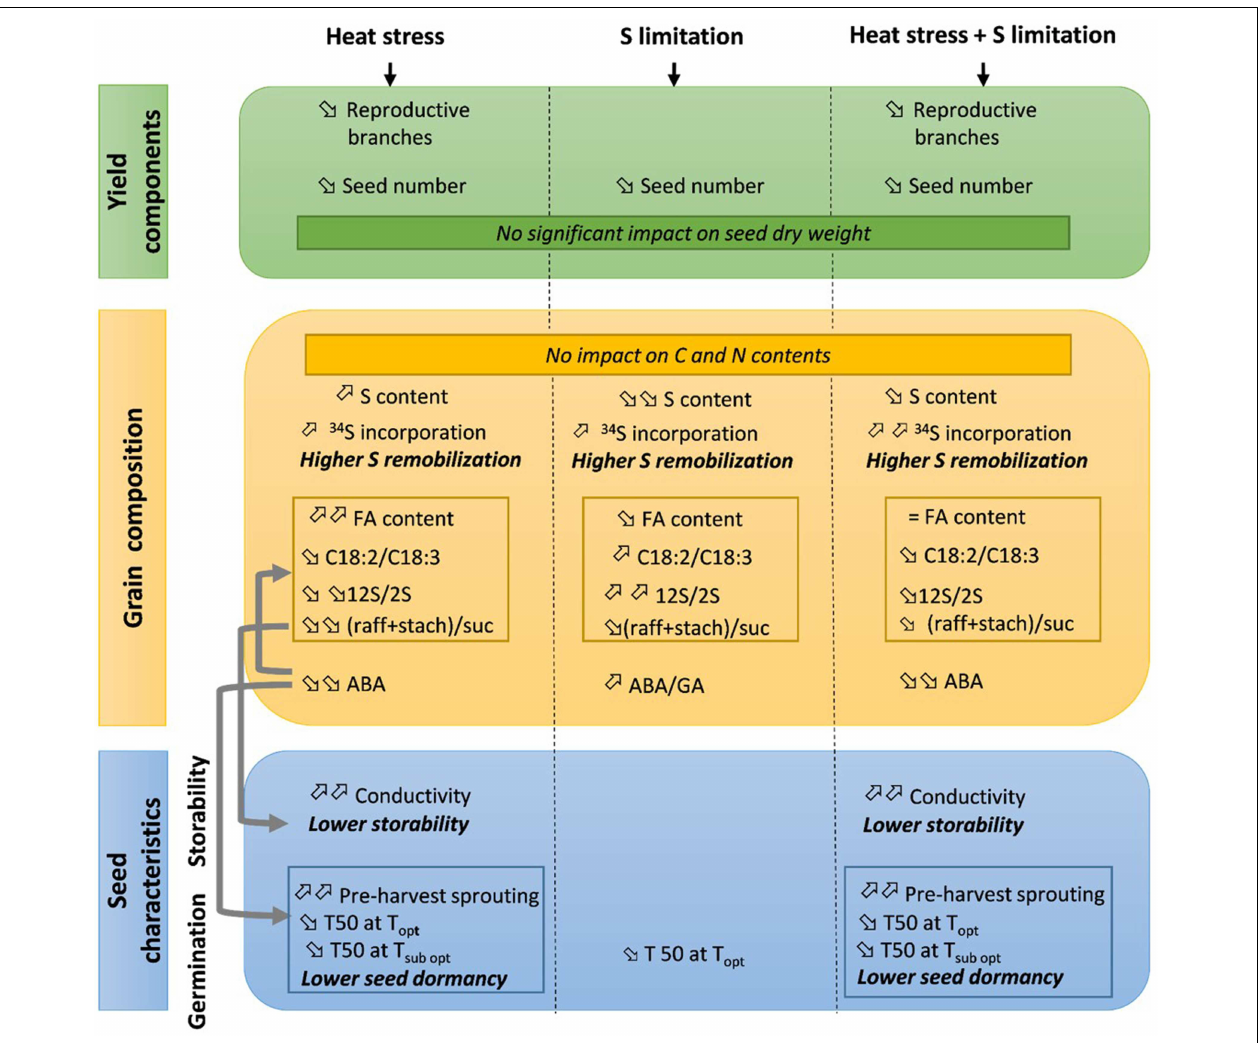
given in reference to control plants (Ctrl T-HS). Gray arrows indicate known relations between variable levels. FA, fatty acids; raff, raffinose; stach, stachyose, suc, sucrose; ABA, absicic acid; GA, gibberelic acid; T50, time to reach 50% of germination; Topt, optimum temperature